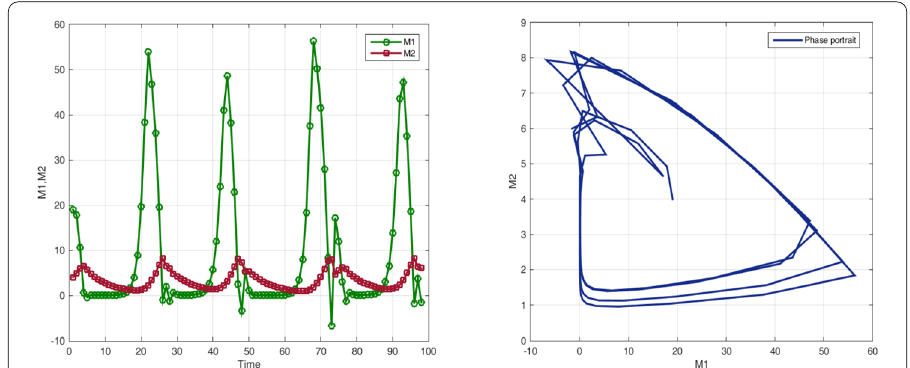
key in controlling information propagation among social networks targeted community or reducing propagating rumors negative effects on human mind and social wellbeing. To support the decision in promoting broadcasted authoritative information and reduce the negative effect of rumor, decision makers need to analyze targeted community’s social ties, network structure and to release the curative content at the right time. The key control parameters m and n will be difficult to determine scientifically with accuracy, as they are related to users’ behavior which is stochastic in nature. 2—By varying control parameters m and n , interaction coefficient value and rescaling population size to 100, we obtained feasible results illustrated in Figs. 8, 9, and 10. A sta- ble coexistence between the current rumor and the related authoritative information is shown. After the release of M 2 via the authority, the trending M 1 containing harmful contents shrinks at relative speed as more and more users enter in contact with M 2 as